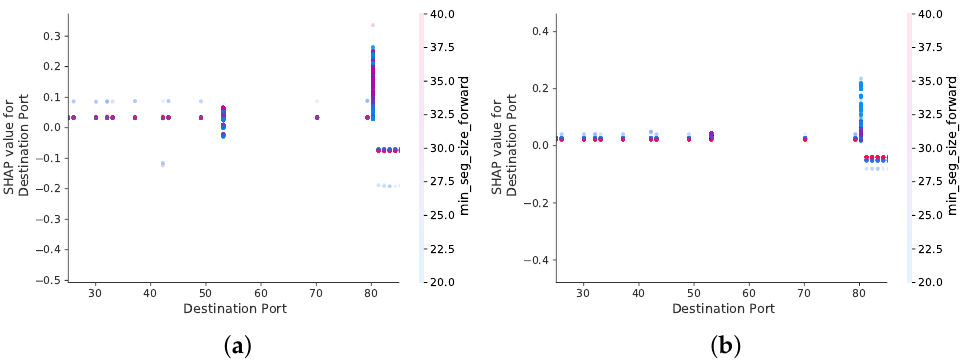
Figure 9. Min seg size forward/Destination Port interaction plots. ( a ) Min seg size forward/ Destination Port interaction for DoS attacks; ( b ) Min seg size forward/Destination Port interac- tion for DDoS